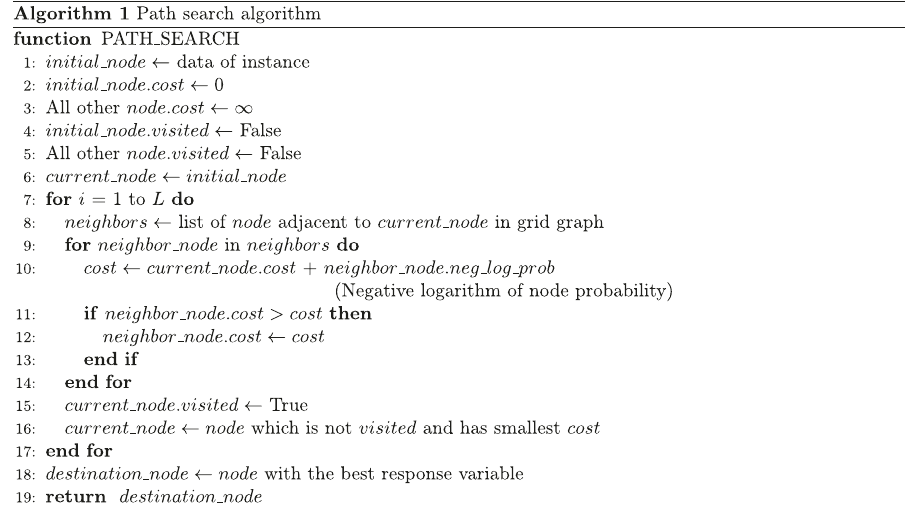
Fig. 3 The intervention variable space was regarded as a grid graph, and the grid points (nodes) were connected to plan a path. The nodal probability was calculated using the surrogate model. The actionability was de fi ned as the product of nodal probabilities on a speci fi ed path. The most actionable (optimal) path for each node was calculated, and the output path was the optimal path to the node with the most improved predictive value within the search iteration count, L . Pseudocode of path search (Supplementary Fig. 3c). This baseline method for the baseline path is de fi ned in “ Methods ” . The planned paths of two randomly selected instances are shown in Fig. 4. We successfully demon- strated that our framework could plan paths to improve response variable values with high probabilities in our framework. Another